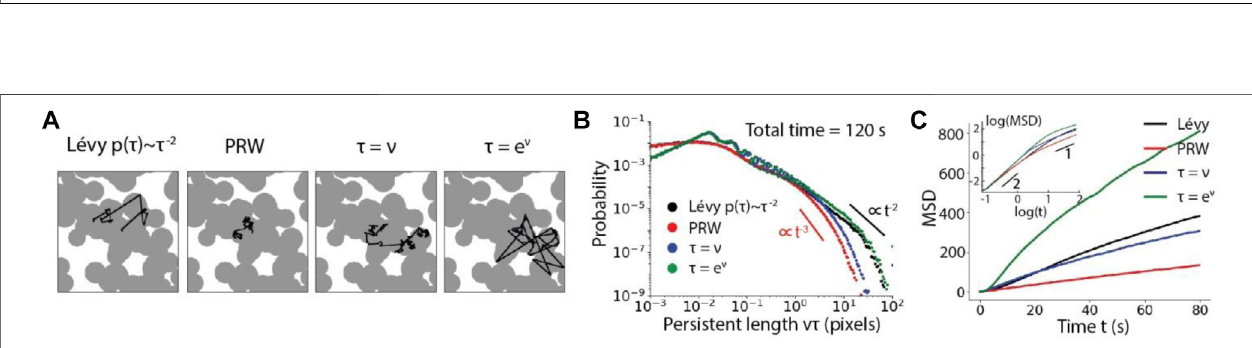
FIGURE7| Particlemobilityin fl uencedbythemovingstrategiesinaconcaveporousenvironment. (A) ,ExampletrajectoriesofLévywalk,PRW,linearRWSP( τ (cid:2) v ) andnonlinearRWSP( τ (cid:2) e v ).Grayareasareinsidetheporesandaccessibletotheparticle.Whiteareasareinaccessible.Blacklinesaretheparticletrajectories. (B) ,The distribution of persistent length, whose tails are well-approximated by power laws with cutoff at large persistent lengths. (C) , Mean square displacements (MSDs) over time.